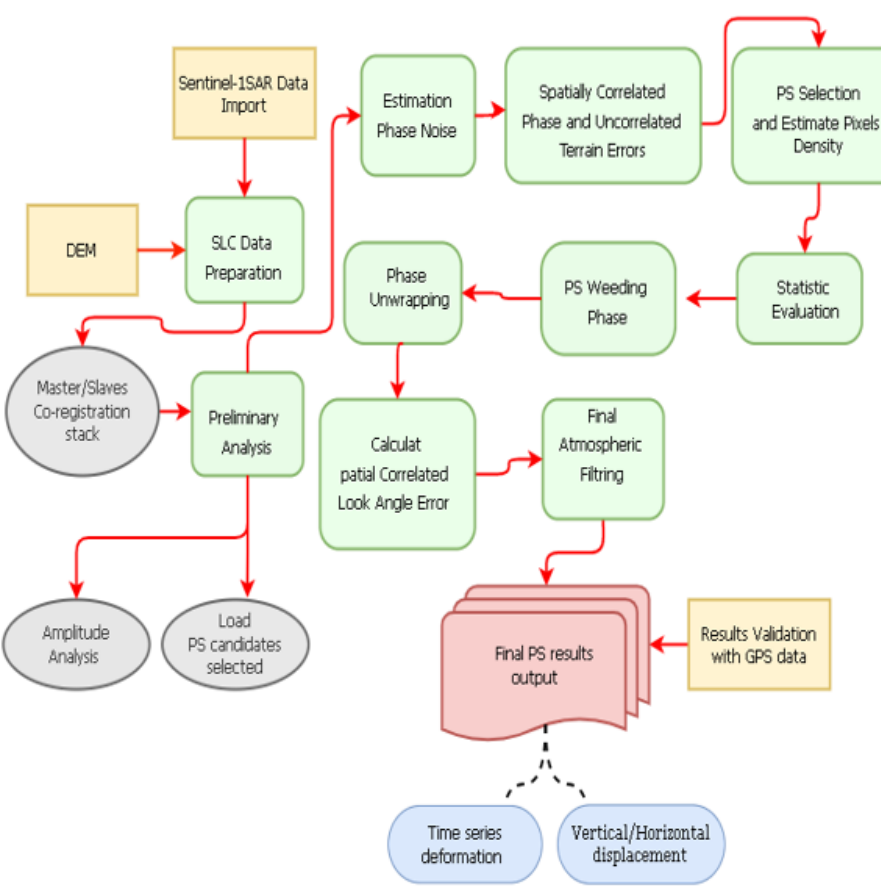
Figure 4. Flowchart depicting the overall methodology adopted in this